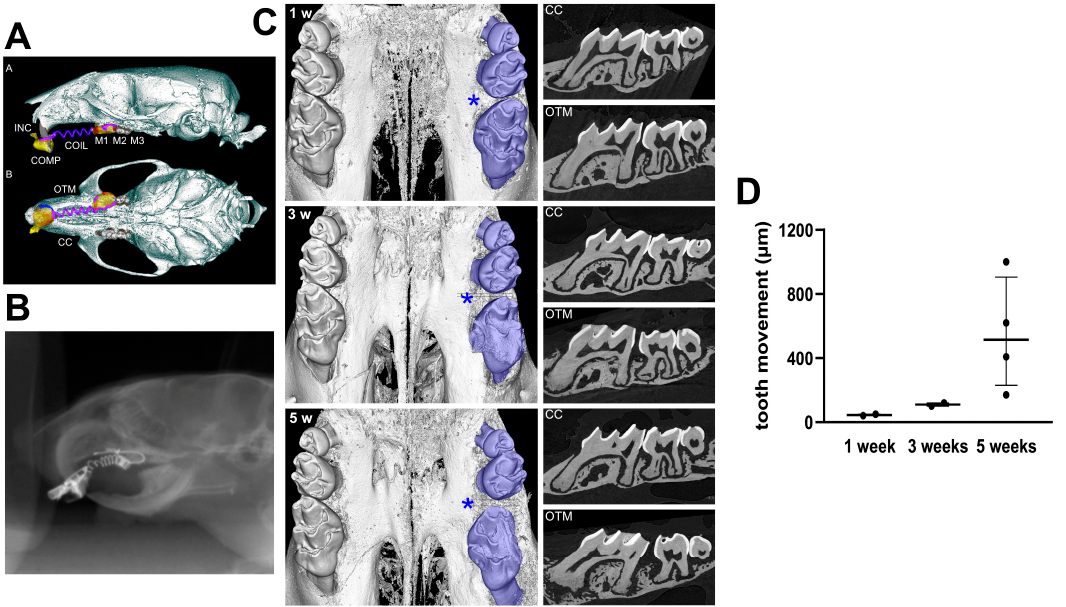
Figure 1. Periodontal remodelling and orthodontic tooth movement after 1, 3, and 5 weeks with a NITi coil spring compared to the untreated contralateral jaw side. ( A ) Orthodontic apparatus employed in mouse maxilla, upper jaw. Schematic representation based on micro-computed tomography scans showing 3-dimensional sagittal and occlusal views of an orthodontic appliance used in mouse. A super elastic coil spring (COIL) was fixed between the maxillary left first molar (M1) and maxillary incisors (INC) using a dental composite (COMP) to achieve mesial (anterior) movement. The loaded side is labelled as the orthodontic tooth movement (OTM) side, while the contralateral control (CC) side received no orthodontic appliance. ( B ) Imaging of mouse under isoflurane anaesthesia during CT scans. ( C ) Three-dimensional and two-dimensional micro-CT reconstruction of mouse maxillary molars under OTM or CC sides. Displacement of the first maxillary molar (MI) from contact with the second molar (M2) is indicated by asterisk. Occlusal view displaying both OTM and CC sides, with asterisks indicating greater separation between MI and M2 in WT mice. ( D ) Mesial tooth movement in µ m after NiTi coil spring activation of the first molar during weeks 1, 3, and